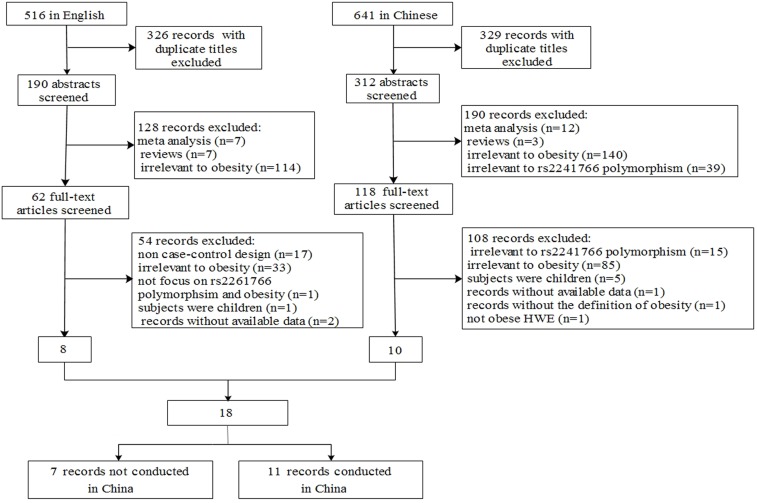
Flow diagram of eligible study selection.